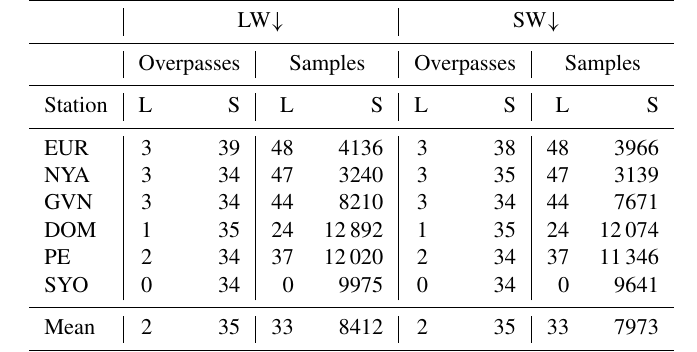
Table 4. Monthly mean total number of unique CloudSat and CALIPSO overpasses and total number of individual CloudSat and CALIPSO samples for the limited-distance sampling technique <10km from the POI (L) and the smart sampling approach (S).